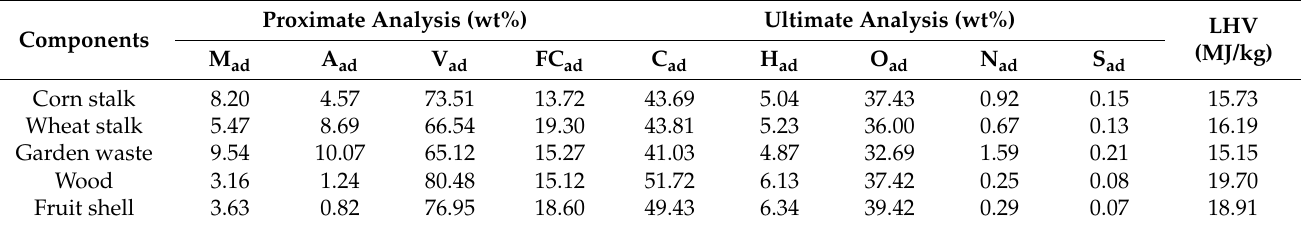
Table 1. The proximate and ultimate analysis of different types of